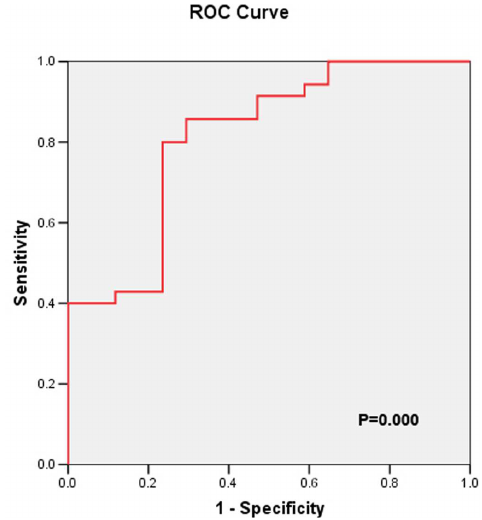
Fig 3. ROC-AUC of non transient AKI according to uKIM-1